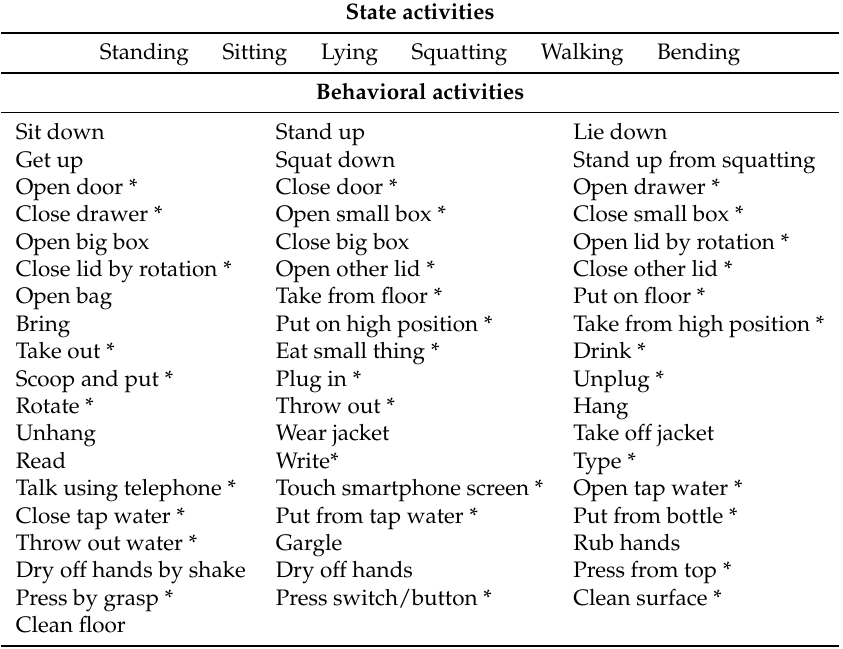
Table 2. List of the state and behavioral activities of the Cognitive Village dataset. For activities with a * symbol, executions with either the left or right hand were distinguished.